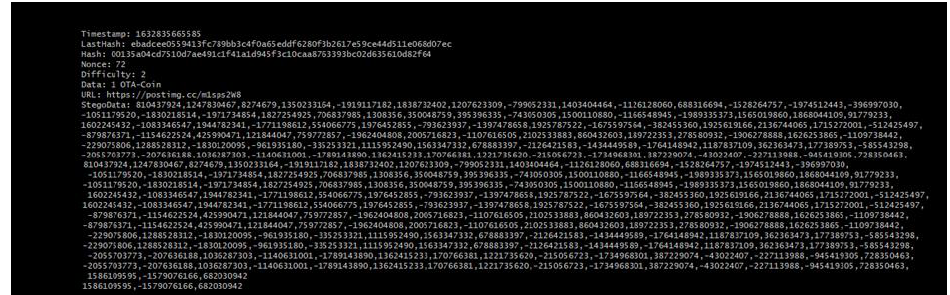
Figure 7. Example of OTA-Chain Transaction.